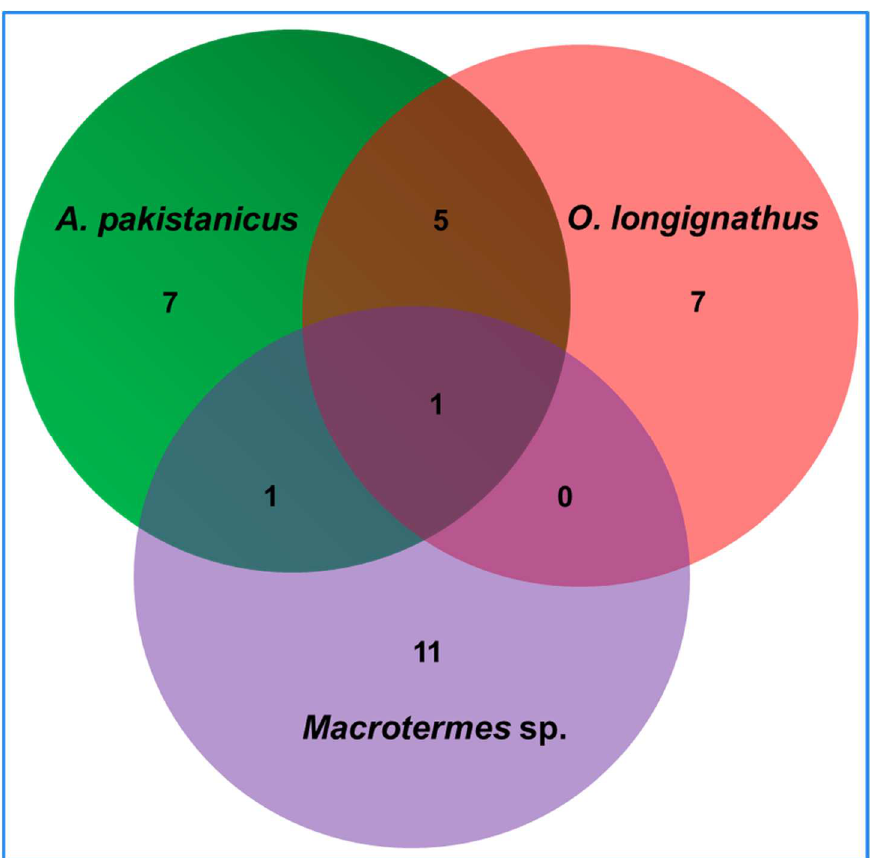
Figure 3. The Venn plot demonstrates the number of unique and shared bacterial species between the fungus-growing termites under consideration. The bacteria were identified after their capability to grow on Avicel and xylan substrates.